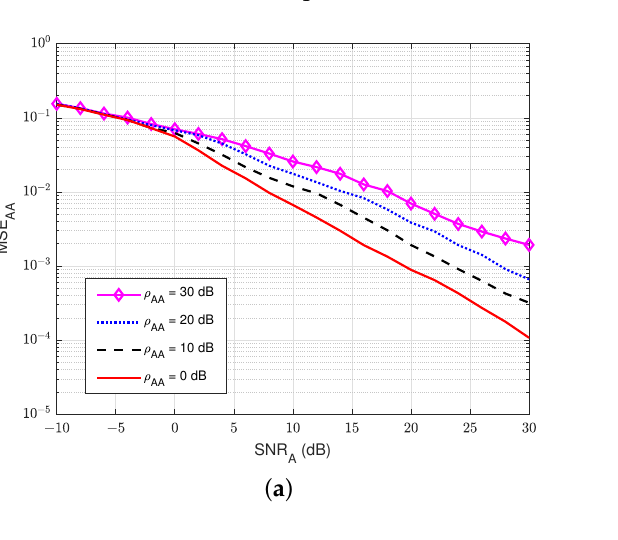
Figure 7. MSE AA versus SNR A in case of passive eavesdropper: ( a ) Blind without feedback; ( b ) Blind feedback.